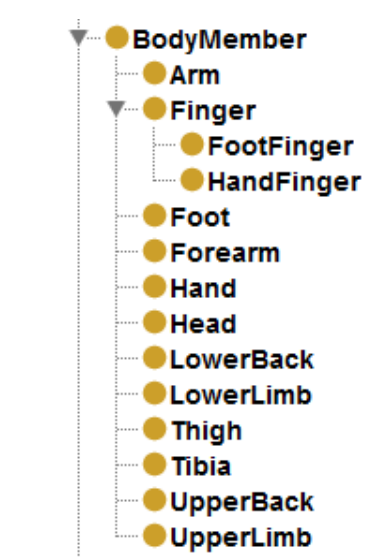
Figure 7. Explicit taxonomies for joints and body members. Joint taxonomy: Body member